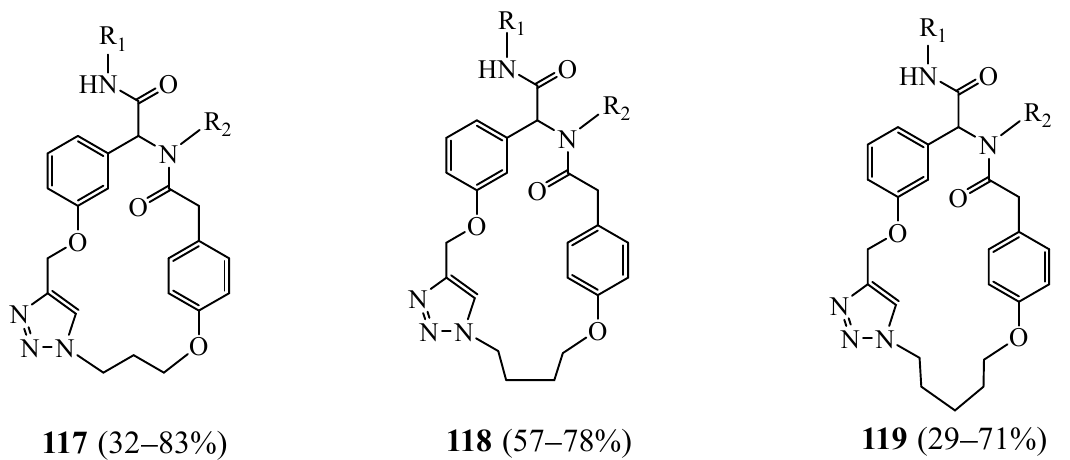
Figure 28. General structures of monatriazolic macrocycles 117 − 119. (Reprinted with permission from ref. [48]. Copyright 2018 John Wiley and Sons).